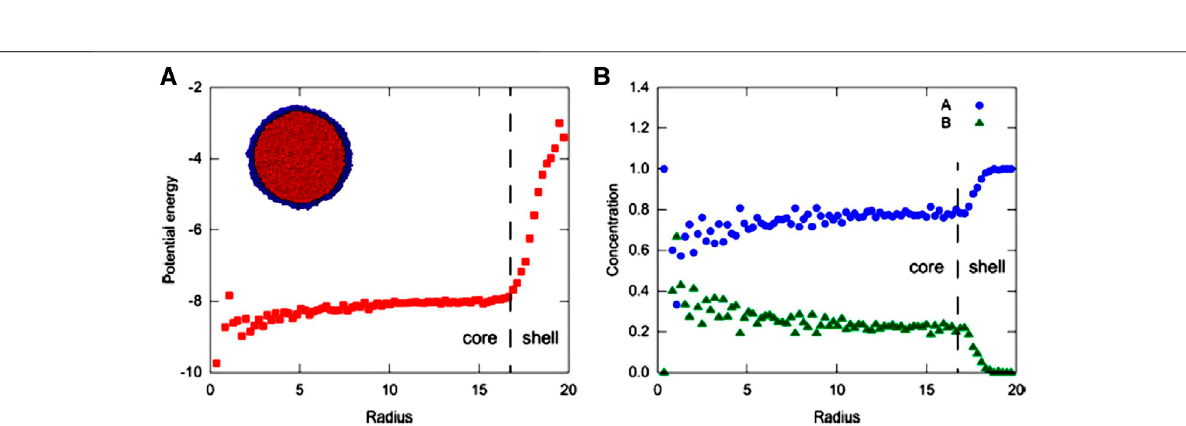
Frontiers in Materials |